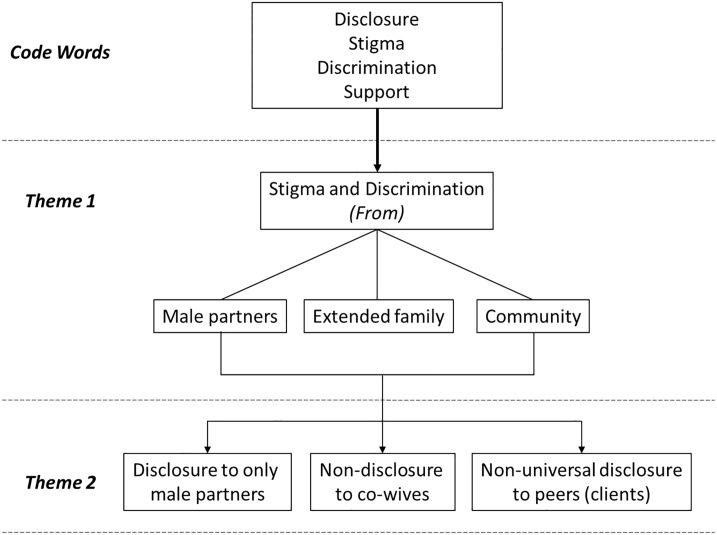
Themes from qualitative data analysis: Disclosure among expert mothers.